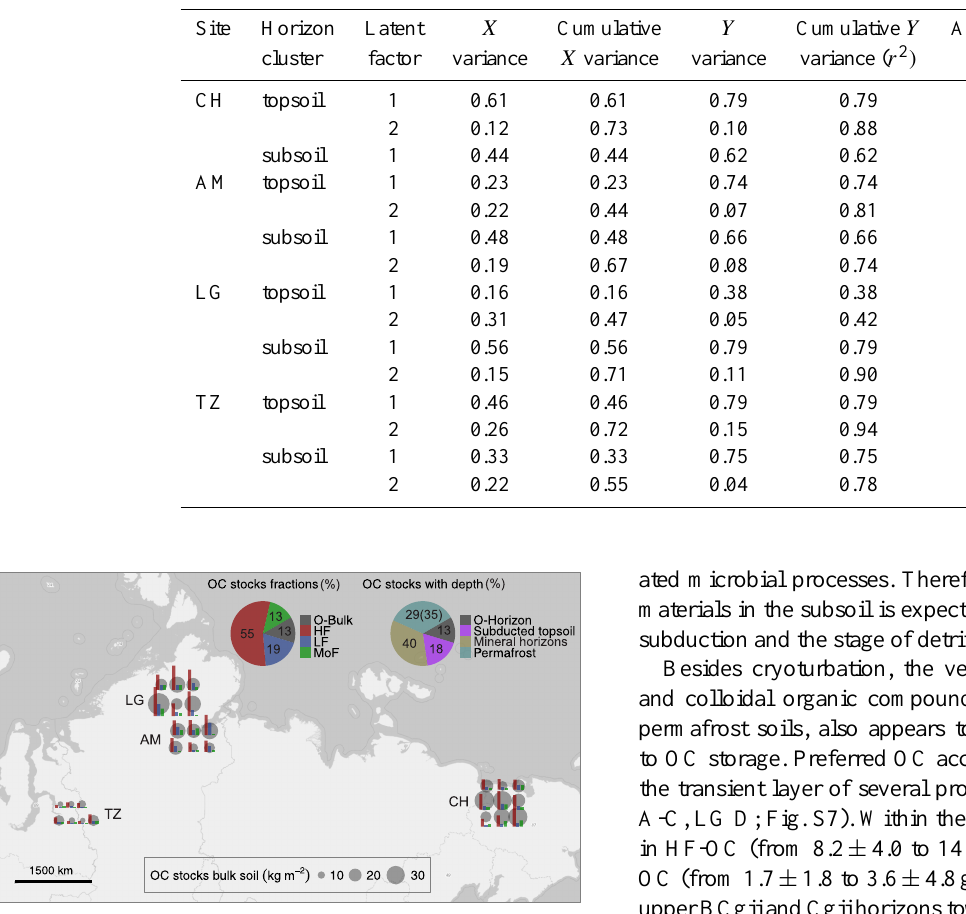
Figure 8. OC distribution map across the Siberian sampling sites. The grey circles show the total OC stock for each profile individu- ally and the coloured bars present the proportion of the specific OM fraction. The pie charts summarize all of the soil profiles. Note that the percentage of permafrost OC summarizes all profiles, while the number in brackets includes only profiles with permafrost within 100cm